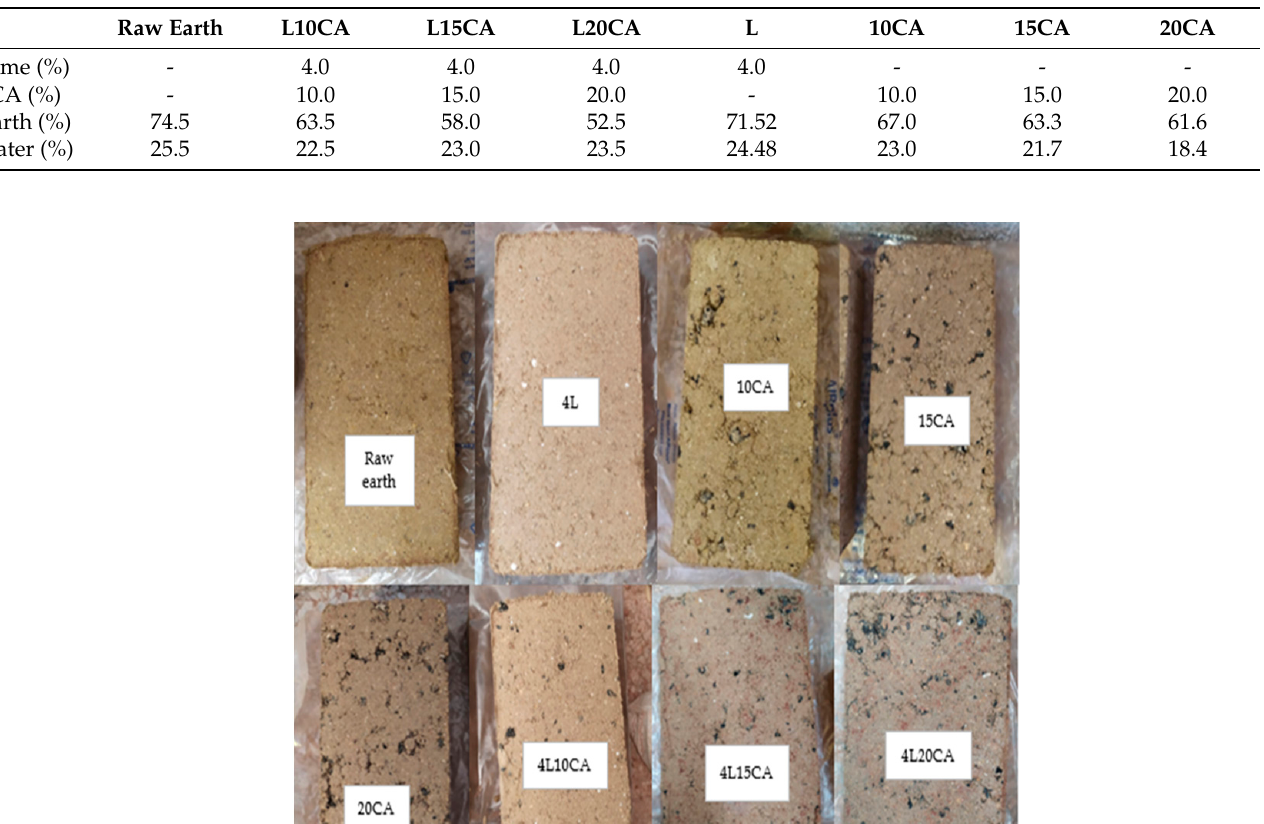
Table 3. Formulations composition.